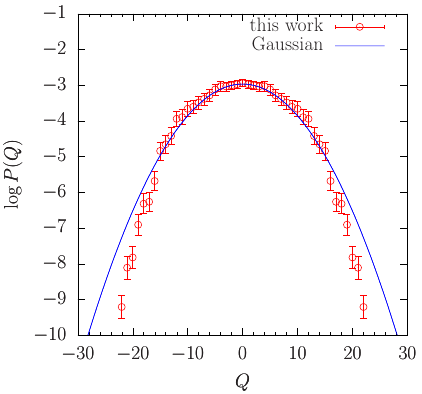
Figure 6. The logarithm of the topological charge distribution P p Q q on the 32 4 lattice, compared to a Gaussian